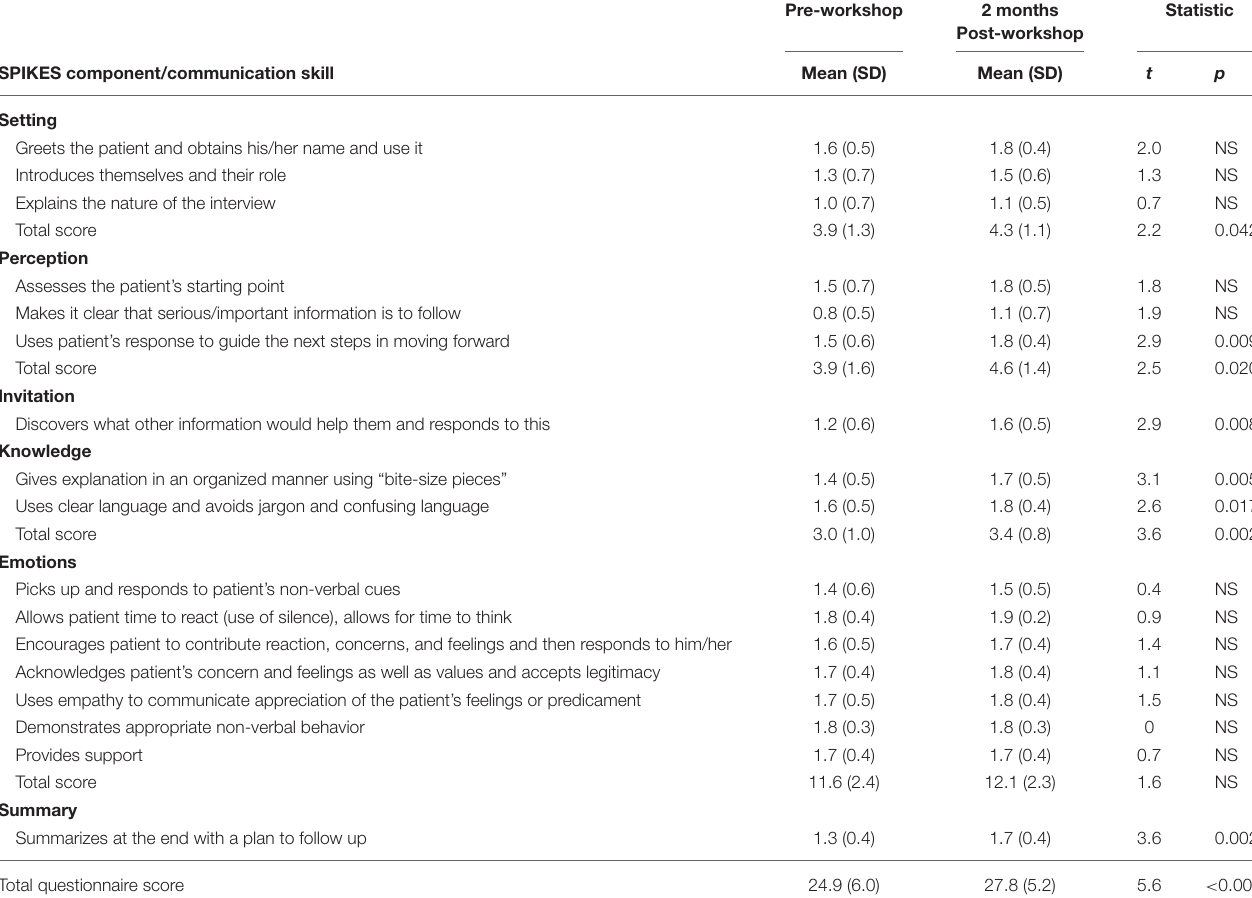
TABLE 1 | Evaluators’ scores on communication skills, blinded to the time period (before the workshop and 2 months